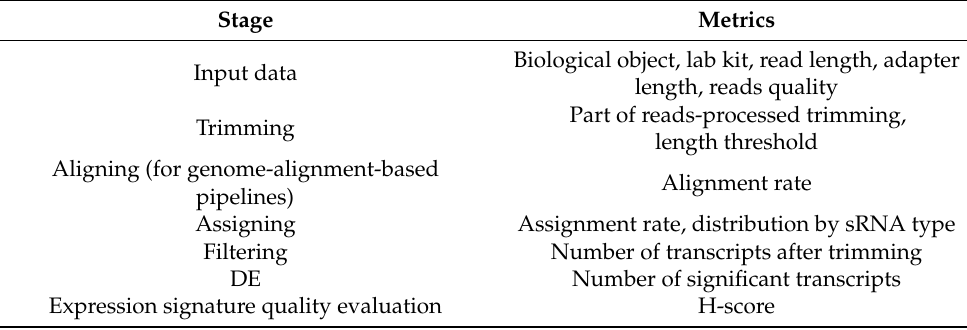
Table 5. Metrics for benchmarking according to stage of bioinformatic analysis. Stage Metrics Biological object, lab kit, read length, adapter Input data length, reads quality Part of reads-processed trimming, Trimming length threshold Aligning (for genome-alignment-based Alignment rate pipelines) Assigning Assignment rate, distribution by sRNA type Filtering Number of transcripts after trimming DE Number of significant transcripts Expression signature quality evaluation